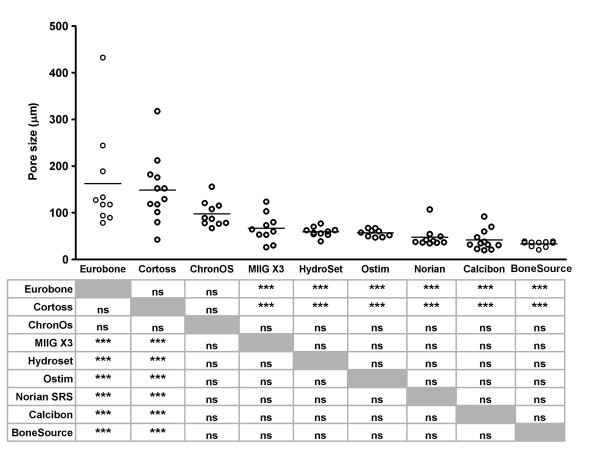
Average pore sizes of bone substitutes Average pore sizes of individual test samples were determined upon Micro-CT-scanning as described in the Materials and Methods. Each dot represents an individual test sample, and lines indicate the average value. The table below the figure shows the outcome of the pairwise comparisons (Student's T-test with Bonferroni correction). *, p < 0.05; **, p < 0.01; ***, p < 0.005; ns, not statistically significantly different. Grey boxes represent the self-self combinations, which could not be tested.